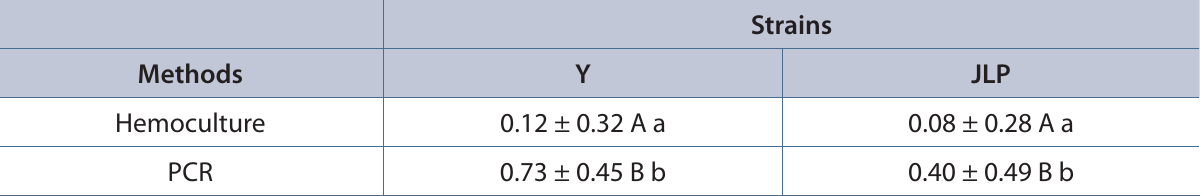
Table 2. Comparison between strains and methods (hemoculture versus PCR) in heart samples from BALB/c mice infected with T. cruzi strain Y or strain JLP